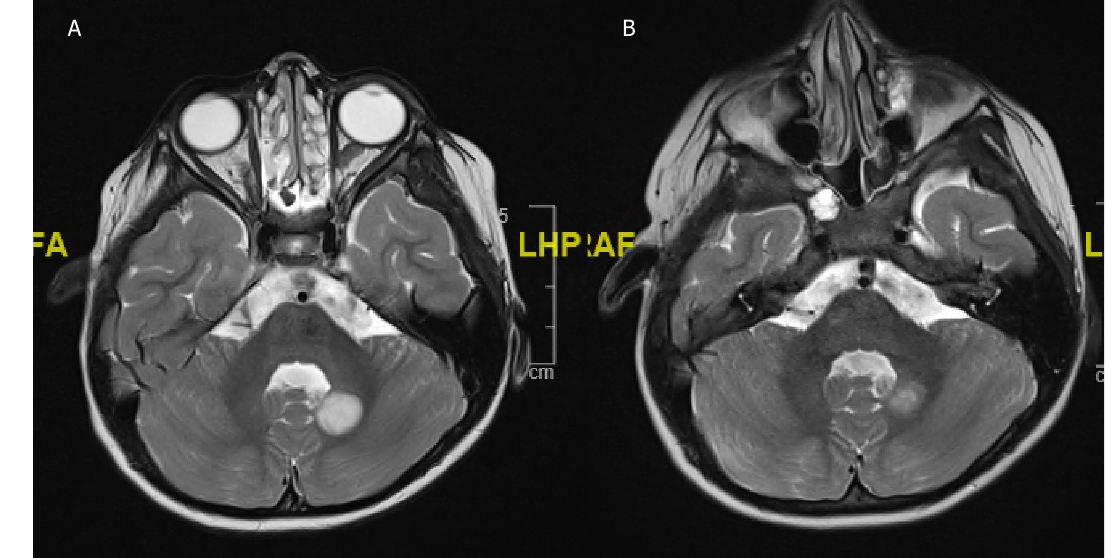
Figure 4. An 8 year-old girl undergoing treatment for congenital scoliosis. ( A ) MRI head carried out in the setting of her scoliosis work-up showed an incidental finding of a T2 hyperintense cerebellar lesion ( B ) Interval scan after 6 months showed a spontaneous regression of the lesion. No resection or biopsy was attempted.